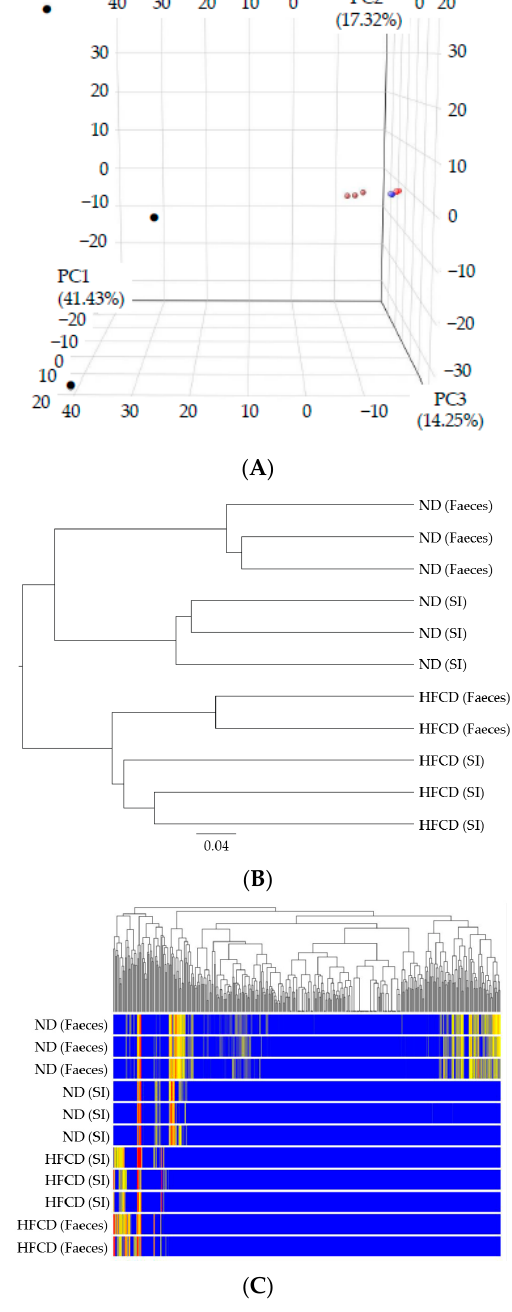
Figure 1. Principal-components analysis and clustering analysis in ß-diversity analysis. ( A ) Principal-components analysis of microbiota populations of small intestines and feces in stroke-prone spontaneously hypertensive-5 (SHRSP5) rats fed normal diet (ND) or high-fat- and high-cholesterol- containing diet (HFCD) by plotted unweighted UniFrac distances [15,17]. Microbiota of small intestine in SHRSP5 rats fed ND were more similar to those of small intestines or feces in SHRSP5 rats fed HFCD than to those of feces in SHRSP5 rats fed ND. Small intestine (SI) in SHRSP5 rats fed ND (small brown circles, n = 3), feces in SHRSP5 rats fed ND (small black circles, n = 3), small intestines in SHRSP5 rats fed HFCD (small red circles, n = 3), and feces in SHRSP5 rats fed HFCD (small blue circles, n = 2). ( B ) Clustering analysis in ß-diversity analysis of microbiota populations of small intestines and feces in SHRSP5 rats fed ND or HFCD. ( C ) Results of clustering analysis. Data were analyzed using GeneSpring GX software. Microbiota of feces in SHRSP5 rats fed ND belonged to different